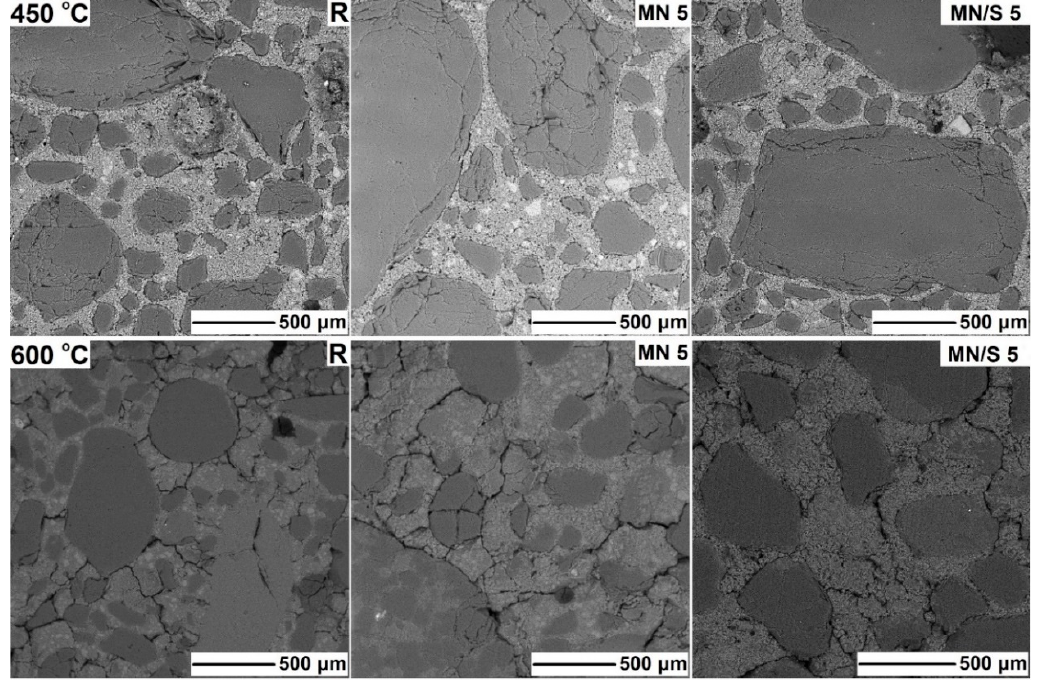
Figure 27. SEM micrographs of cement mortars containing 5% nano-Fe 3 O 4 (MN 5), 5% nano- Figure 25. SEM micrographs of cement mortars containing 5% nano-Fe 3 O 4 (MN 5), 5% Fe 3 O 4 /SiO 2 (MN/S 5), and reference specimen (R) exposed to 450 °C ( top ) and 600 °C ( bottom ) nano-Fe 3 O 4 /SiO 2 (MN/S 5), and reference specimen (R) exposed to 450 ◦ C ( top ) and 600 ◦ C ( bottom ) (Reprinted with permission from [55]. Copyright 2018 Elsevier). (Reprinted with permission from [55]. Copyright 2018